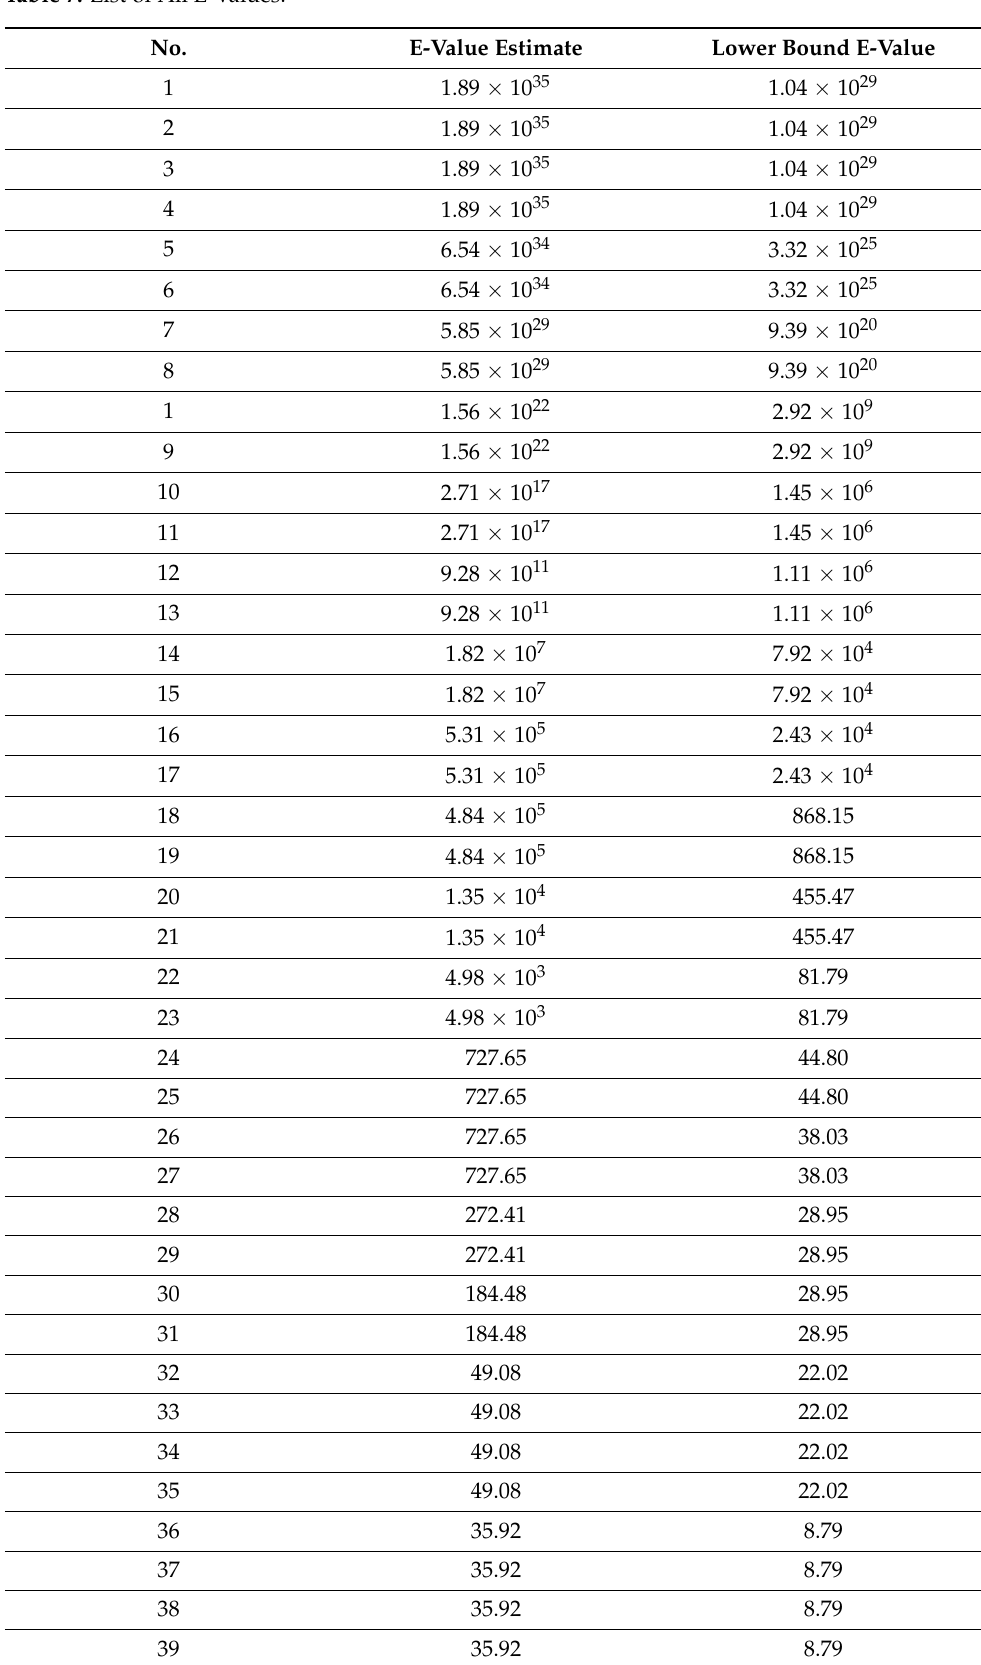
Table 7. List of All